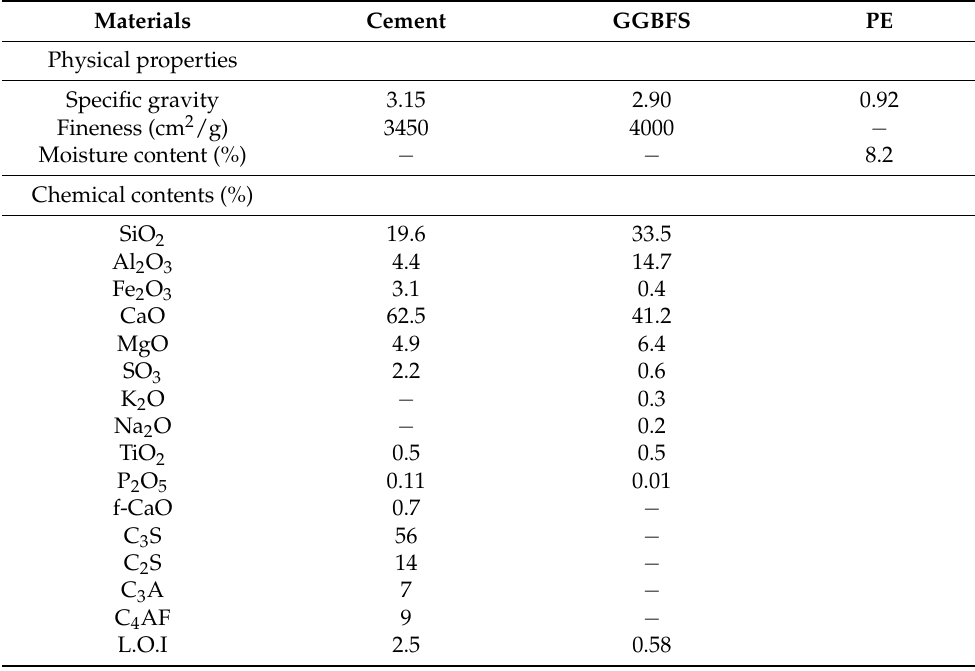
Table 1. Physical properties and chemical composition of test materials.